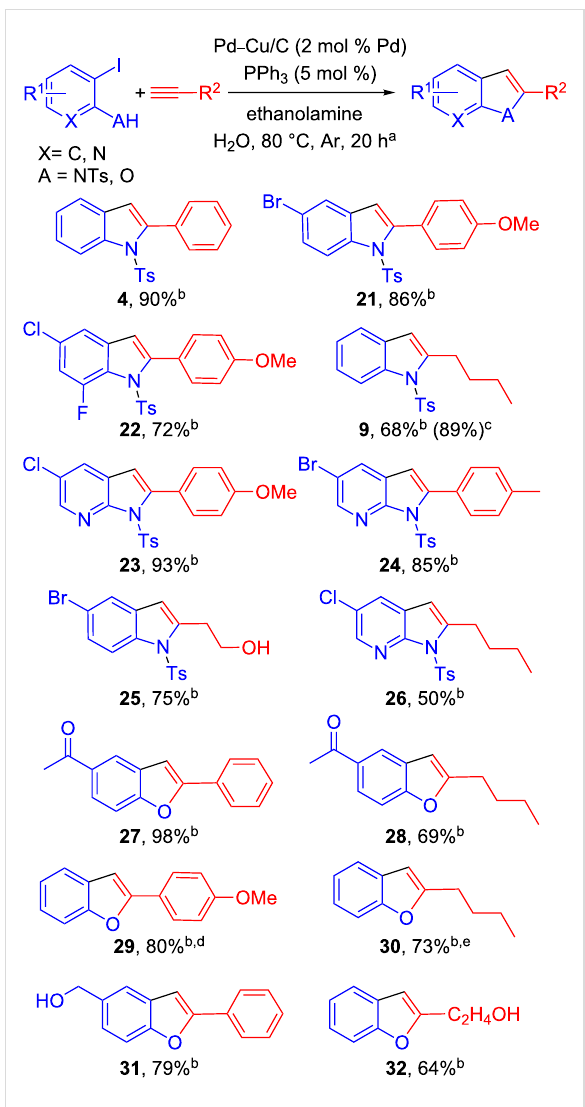
Scheme 5: Preparation of indoles, azaindoles and benzofurans. a Reaction conditions: 2-iodoaniline (0.5 mmol),